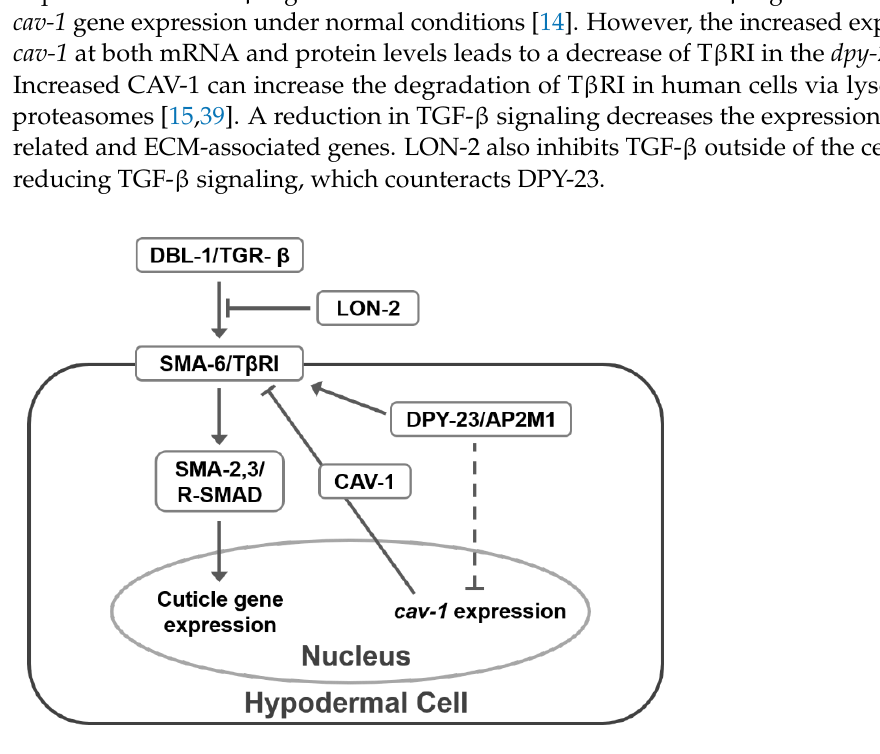
Figure 6. Model for DPY‐23, LON‐2 and CAV‐1 function in TGF‐β signaling. In the hypodermis of C. elegans , TGF‐β signaling promotes collagen expression, which is required for normal cuticle formation. Inhibition of TGF‐β signaling could result in a decreased cuticle gene expression. Outside of the cell, LON‐2 binding to TGF‐β antagonizes TGF‐β signaling. Alternatively, inside of the cell, increased CAV‐1 by the dpy‐23 mutation could decrease TGF‐β signaling through TβRI downregulation.